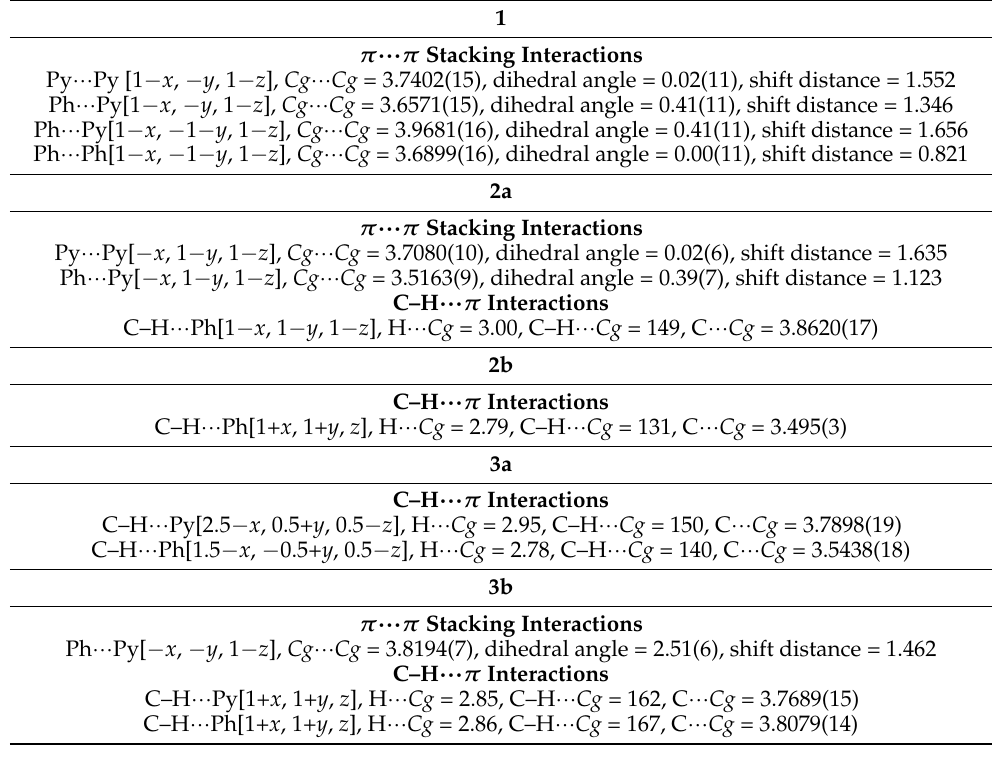
Table 1. π ··· π stacking and C–H ··· π interactions [Å, ◦ ] in title compounds.